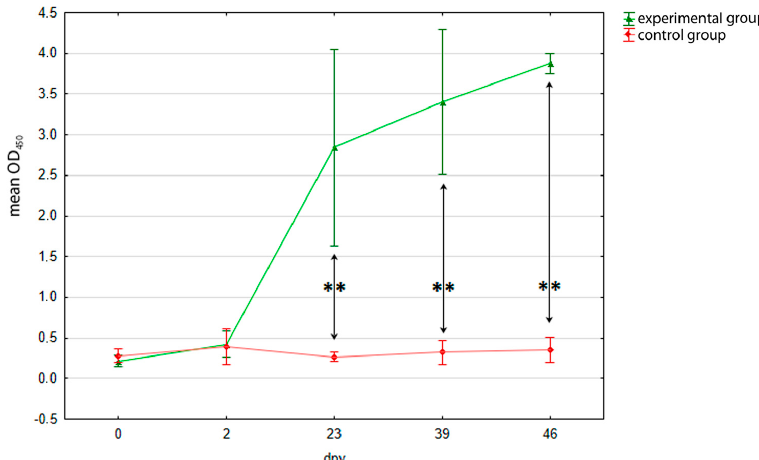
Figure 1. Detection of PiCV rCP–specific IgY in sera of the examined pigeons using in-house ELISA. The pigeons were immunized with PiCV rCP mixed with adjuvant (experimental group, E) or